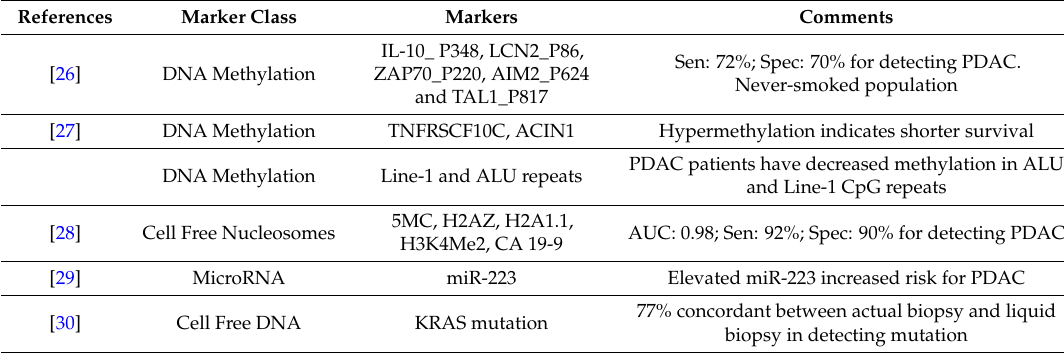
Table 3. Summary of novel serum markers.